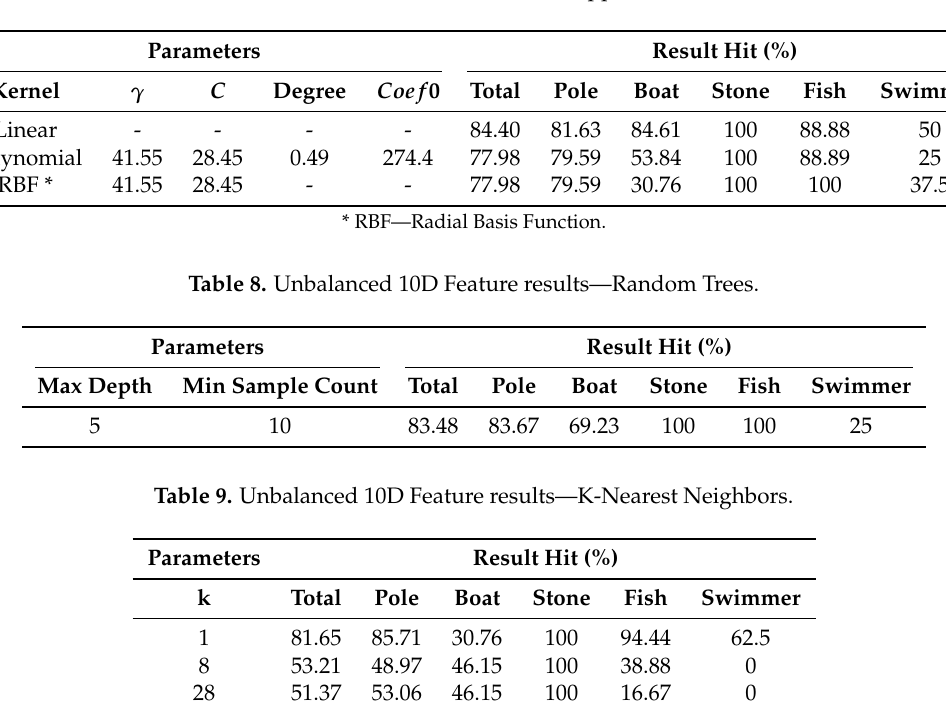
Table 7. Unbalanced 10D Feature results—Support Vector Machine.